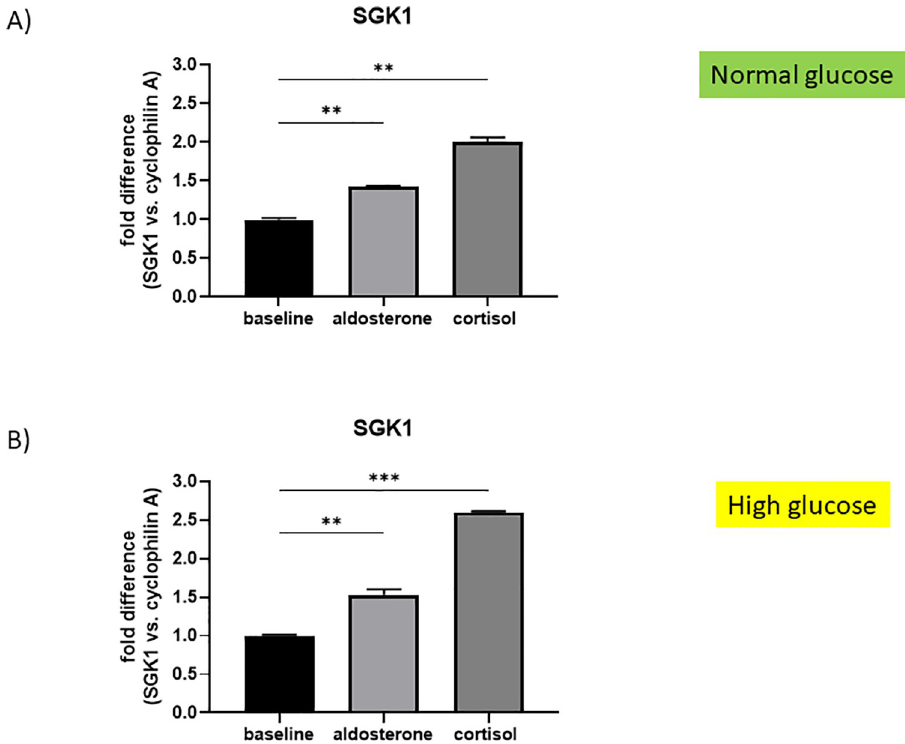
Fig 6. mRNA expression of SGK1 in HRMC in normal and high glucose conditions upon aldosterone and cortisol stimulation. A) mRNA expression of SKG1 in HRMC. Normal glucose conditions (5.25mM). Baseline control was EtOH. Fold difference is shown with cyclophilin A as endogenous control. Aldosterone ( �� p = 0.0026) and cortisol ( �� p = 0.0002) significantly stimulated SGK1 expression in HRMC on a normal glucose background. B) mRNA expression of SGK1 in HRMC. High glucose conditions (25.25mM). Baseline control was EtOH. Fold difference is shown with cyclophilin A as endogenous control. Aldosterone ( �� p = 0.0018) and cortisol ( ��� p < 0.0001) significantly stimulated SGK1 expression in HRMC on a high glucose background. � p < 0.05, �� p < 0.01, ��� p < 0.0001, ns = not